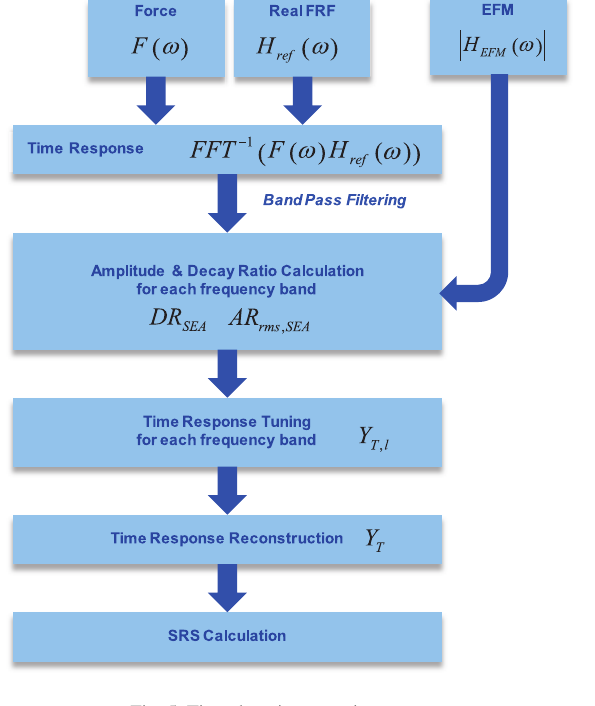
Fig. 5. Time domain correction